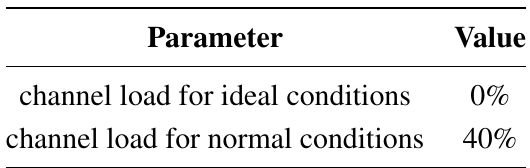
Table 8. Simulation settings for testing the general